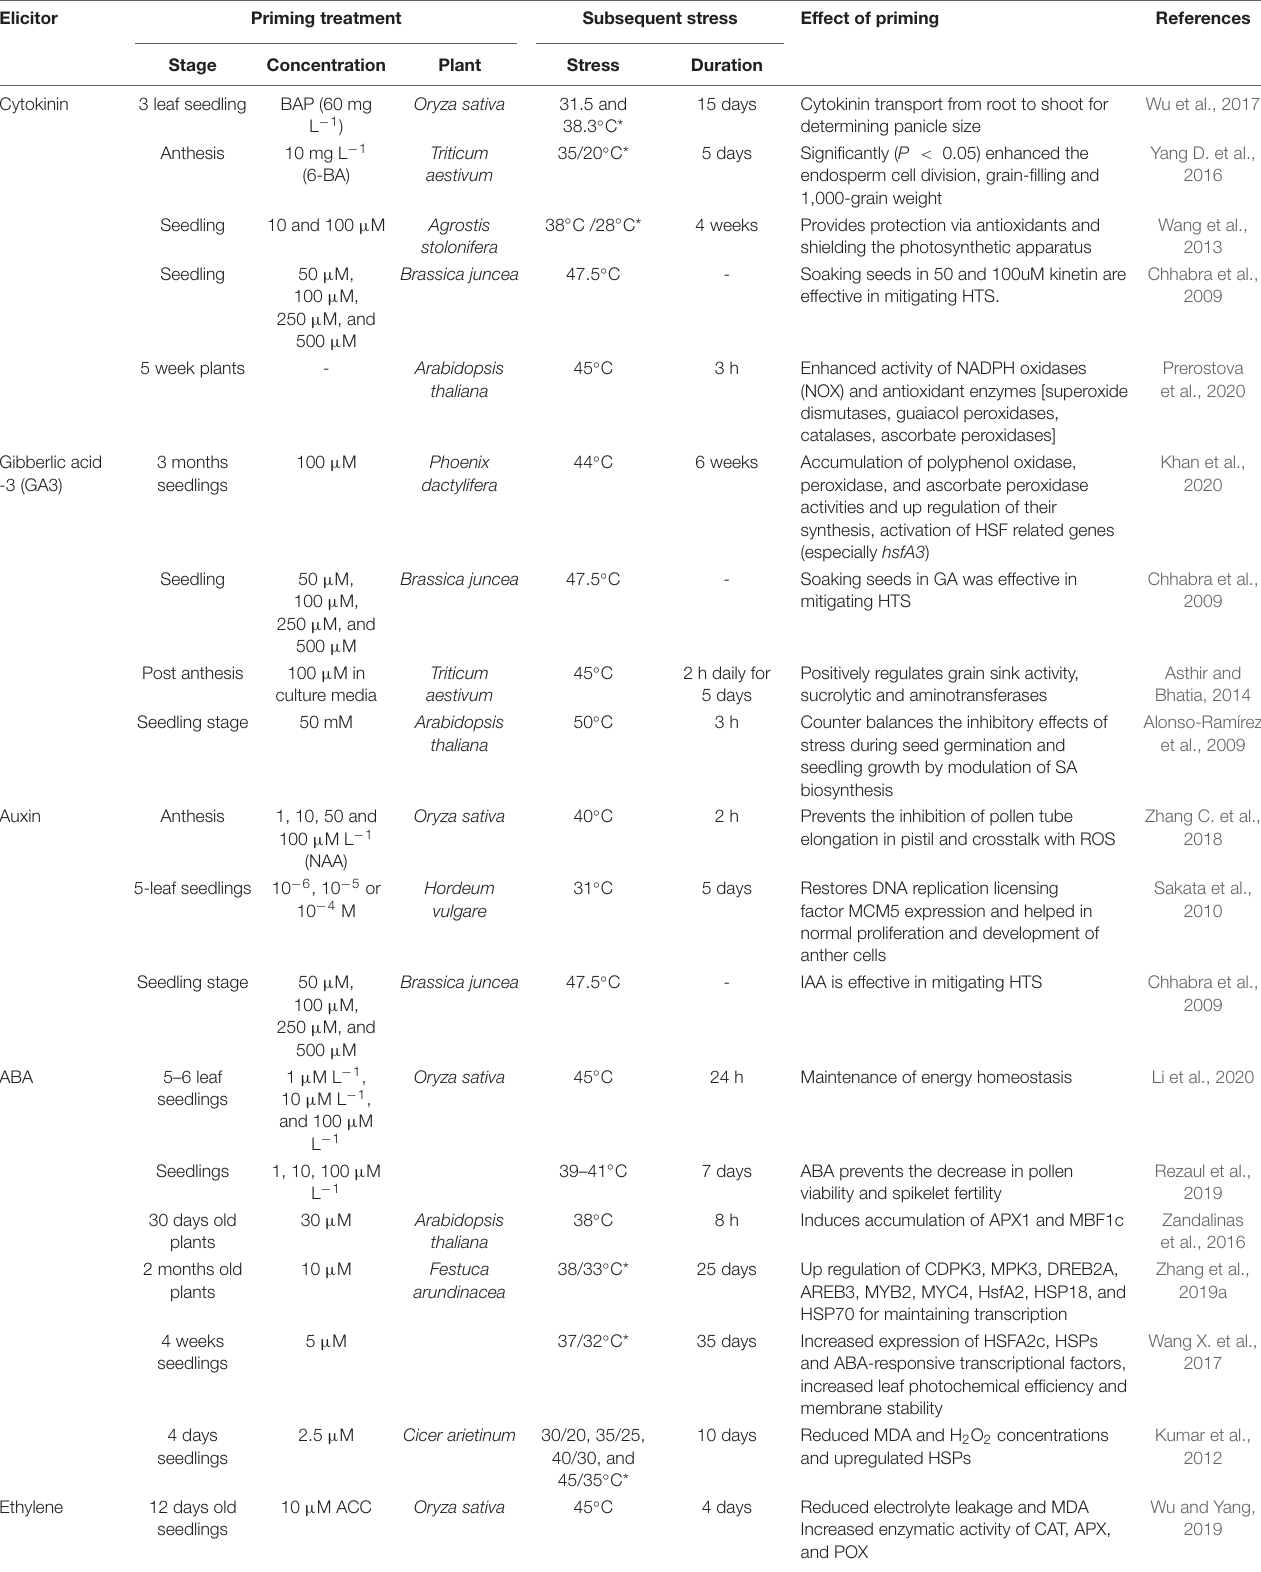
TABLE 2 | Role of hormones in priming plants to high temperature